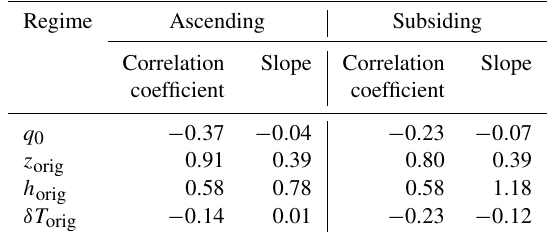
Table 5. As in Table 4 but at the daily scale. The correlation co- efficients and slopes are averaged over all seasons and locations over tropical oceans (30 ◦ N–30 ◦ S, ocean fraction > 80%), sepa- rately for ascending and subsiding